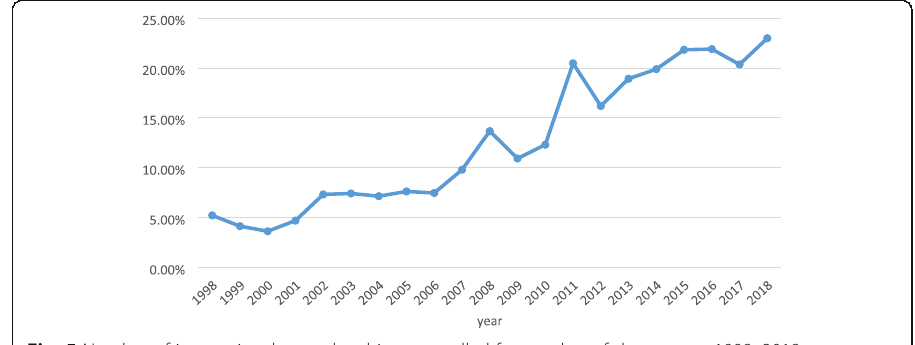
Fig. 5 Number of international co-authorships, controlled for number of documents, 1998 – 2018